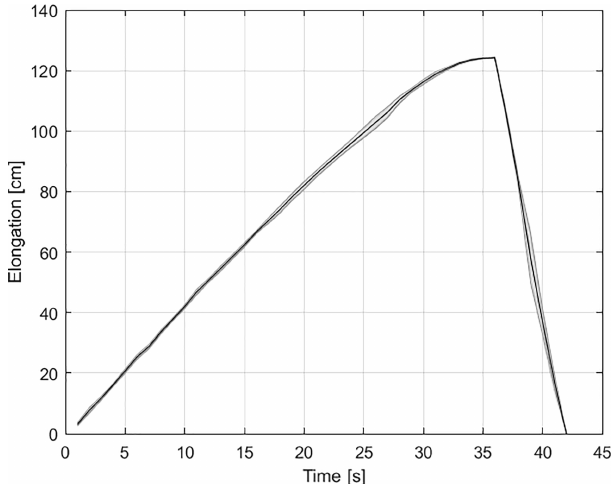
Figure 7. Elongation behavior of the balloons for inflation and de- flation. The solid line represents the mean elongation for seven bal- loons. The shaded area is the standard error of the mean.